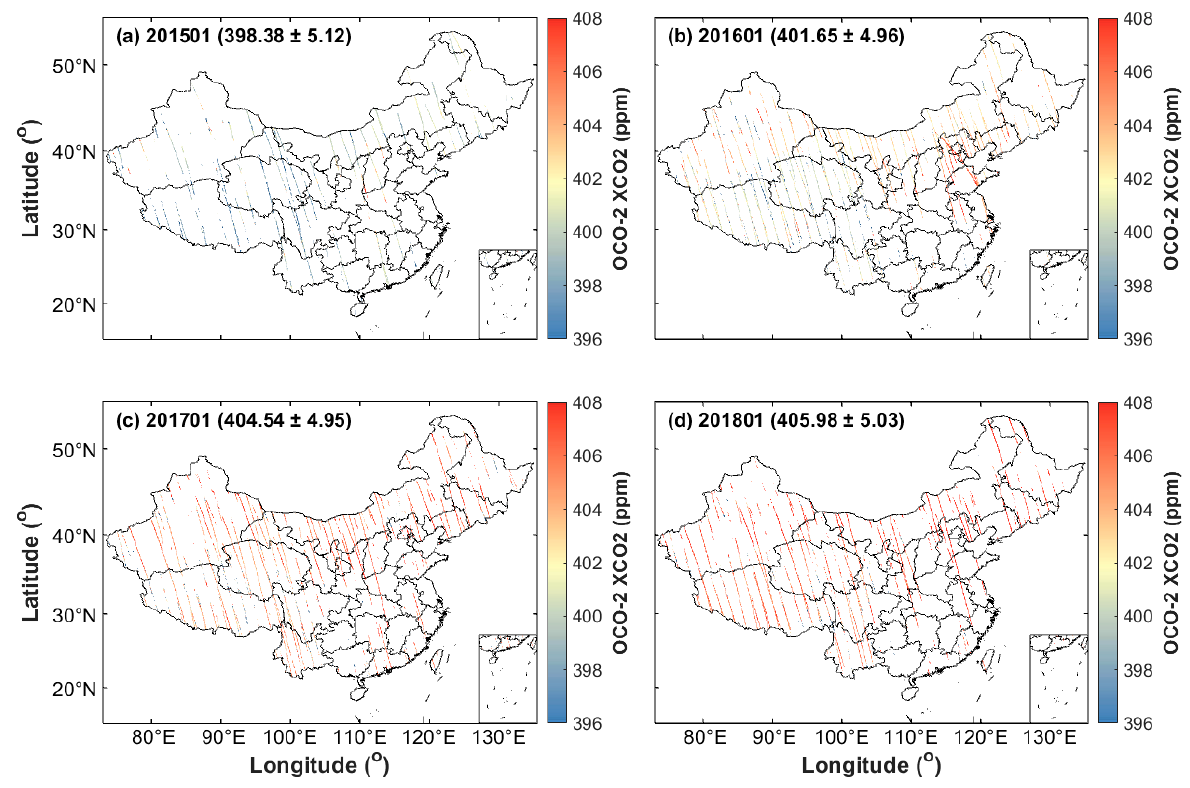
Figure 2. Average monthly data of OCO-2 XCO L2 Lite_FP in China: ( a ) January 2015, ( b ) January 2016, ( c ) January 2017, and ( d ) January 2018.